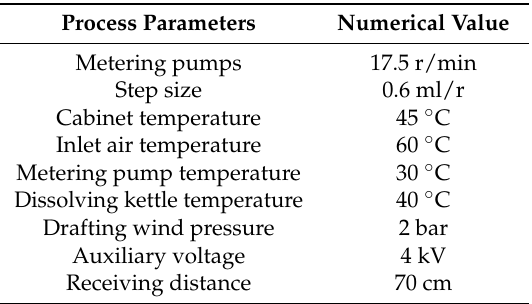
Table 1. Spinning